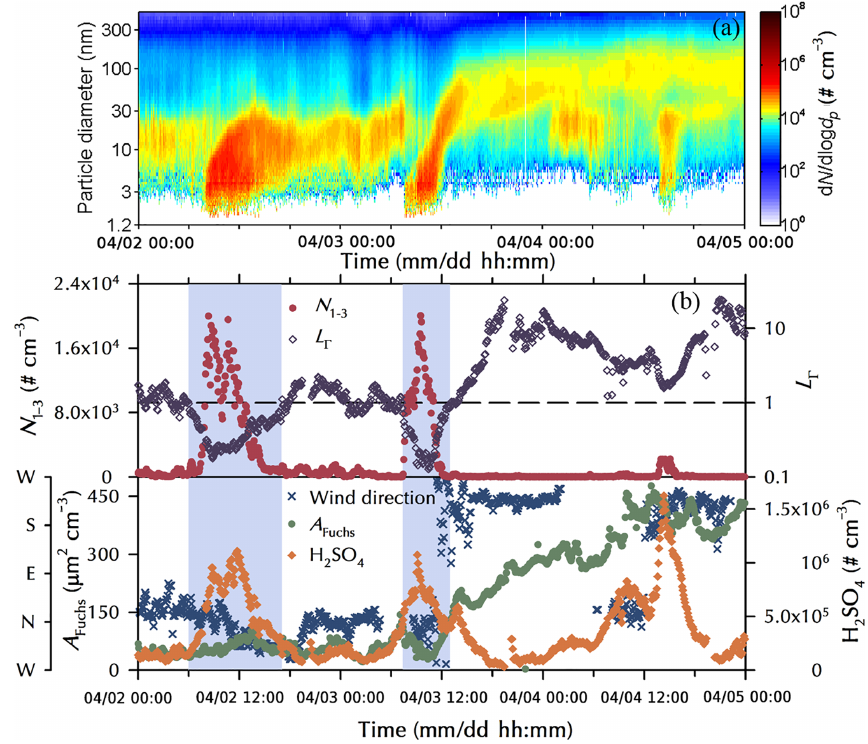
Figure 9. (a) Contour of measured particle size distributions on 2, 3, and 4 April. (b) Representative parameters on these 3 NPF days. Time periods when L (cid:48) was lower than 1.0 are shadowed by light blue background. When wind speed was close to zero, the corresponding wind direction data were not included in the plot.